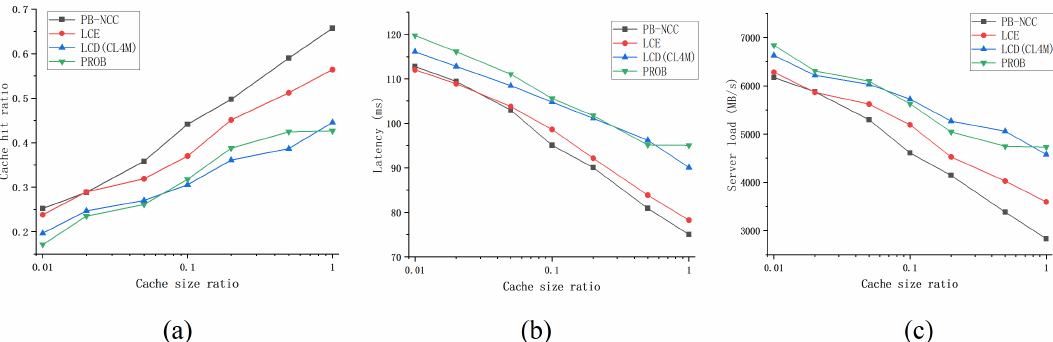
Figure 9. Comparison in the tree topology under YouTube traffic workload. ( a ) the cache hit ratio under a different cache size ratio; ( b ) the average latency under a different cache size ratio; ( c ) the server load under a different cache size ratio.